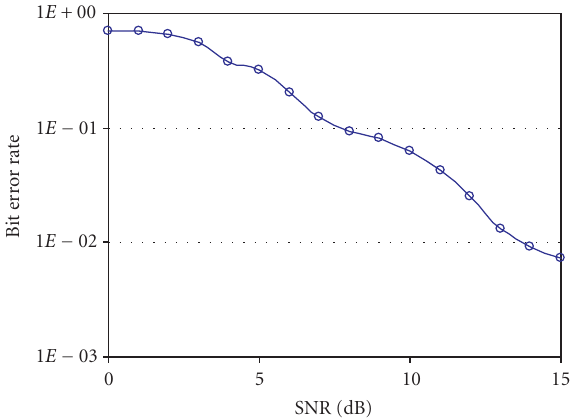
Figure 7: Bit error rate versus